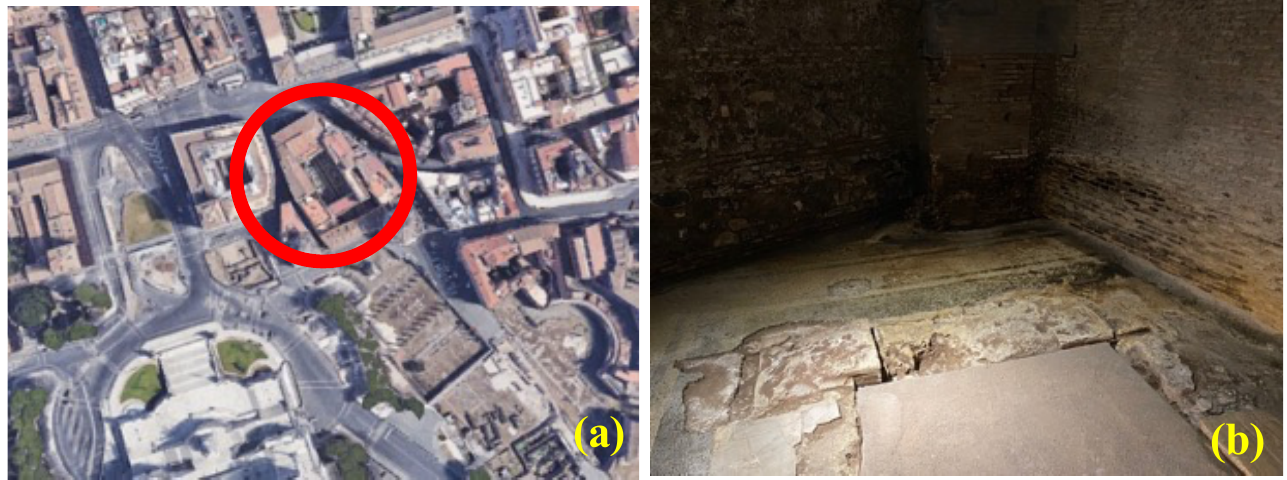
Figure 1. In the red circle is evidenced Palazzo Valentini (source: Google Earth [9]) ( a ). The paviment mosaic and the immediately facing wall ( b ).